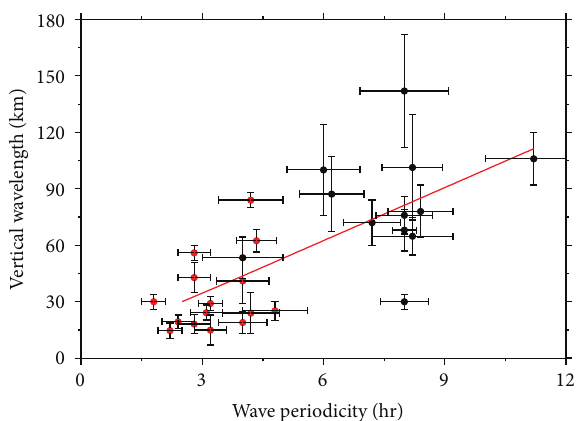
Figure 3: Relation between the wave periodicity and their estimated vertical wavelengths. Filled black and red circles show the results for principal and residual waves,